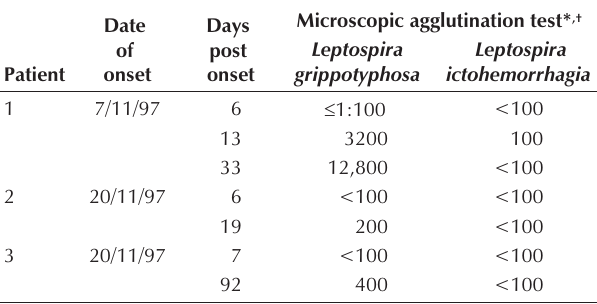
Serology of confirmed leptospira cases from